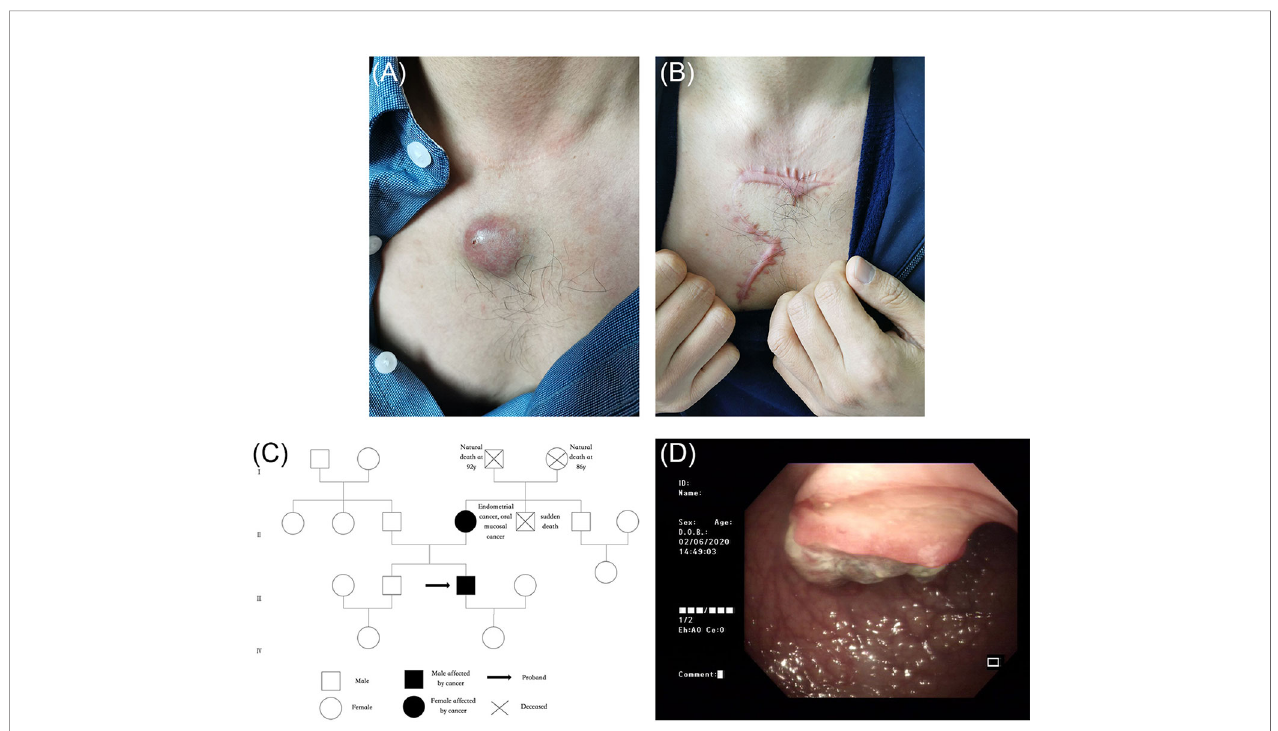
FIGURE 1 | (A) A dark-red hard nodule of 3 cm * 3 cm * 2.5 cm in size was found on the anterior chest, with an opening at the edge. (B) Postoperative scar. (C) The pedigree chart of the index patient (black arrow) and his family. The patient ’ s mother had endometrial and oral mucosal cancer. (D) Colonoscopy showed irregular neoplasms protruding into the intestinal lumen 28 cm away from the anus, with the size of 3 cm * 3 cm whose irregular protrusions in the central part were brittle, hard texture, contact bleeding and covered with soiled